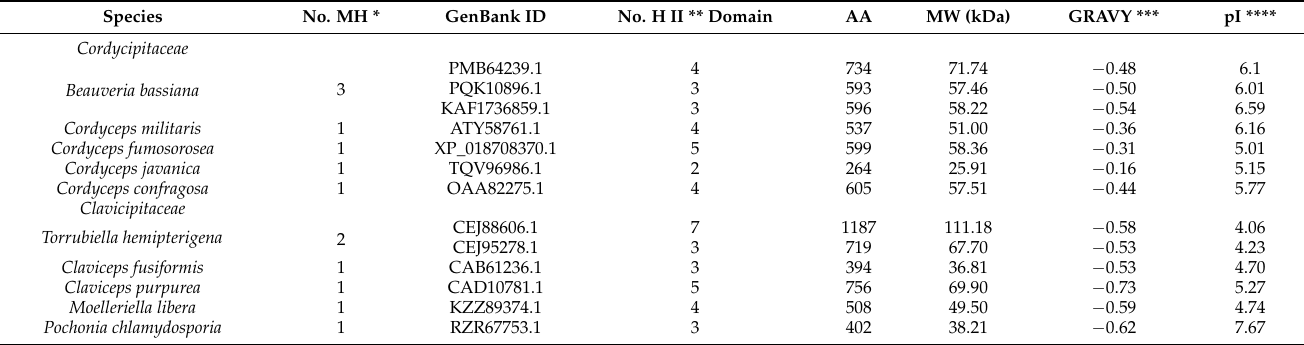
Table 2. The multi-domain hydrophobin proteins found in fungi of Cordycipitaceae and Clavicipitaceae. Species